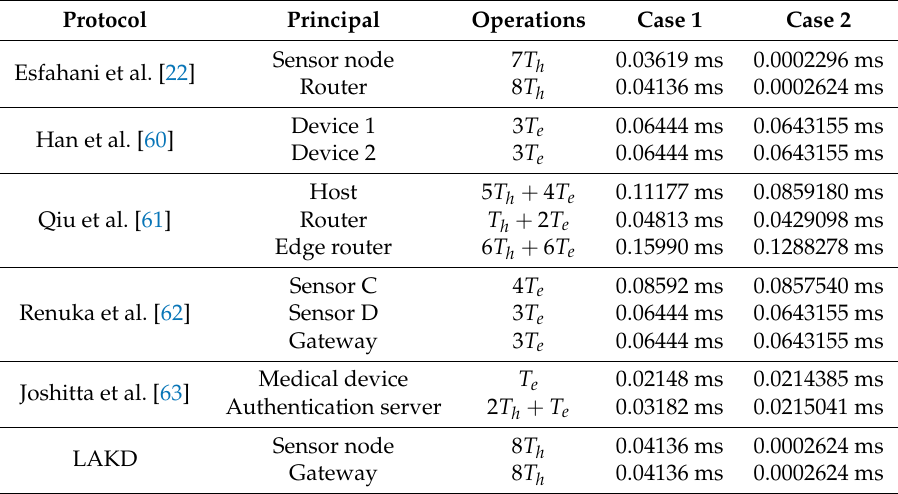
Table 5. Execution-time